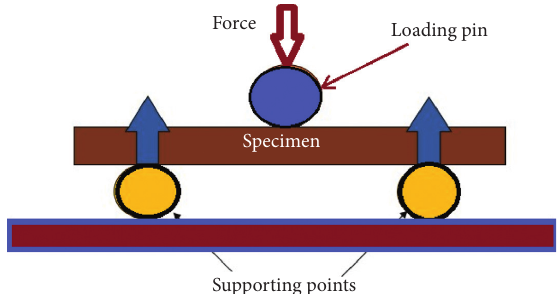
Figure 10: Schematic image of the flexural test setup.